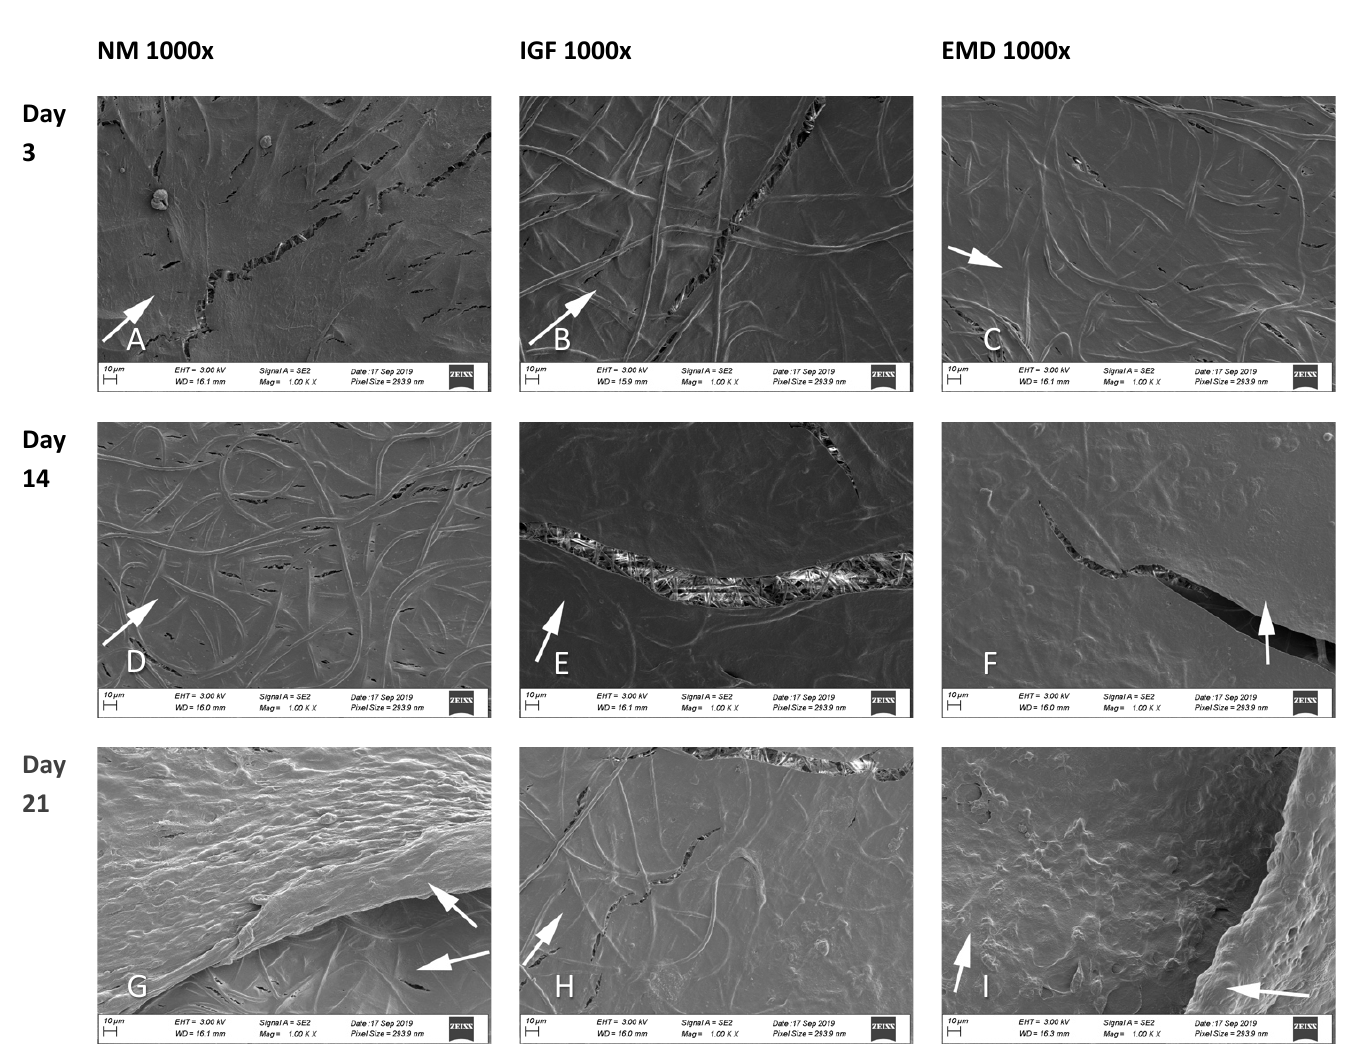
Figure 4. SEM imaging of dental epithelial cell sheets . SEM imaging of in vitro cultured bioengineered tooth bud constructs at days 3 (A-C), 14 (D-F) and 21 (G-I), in the NM (A, D & G), IGF (B, E & H) and EMD (C, F & I) culture condiJons (1000x magnificaJon). All images show a clearly visible DE cell sheet (arrows). The arrows in the SEM images are poinJng at a small piece of the visible DE cell sheet,